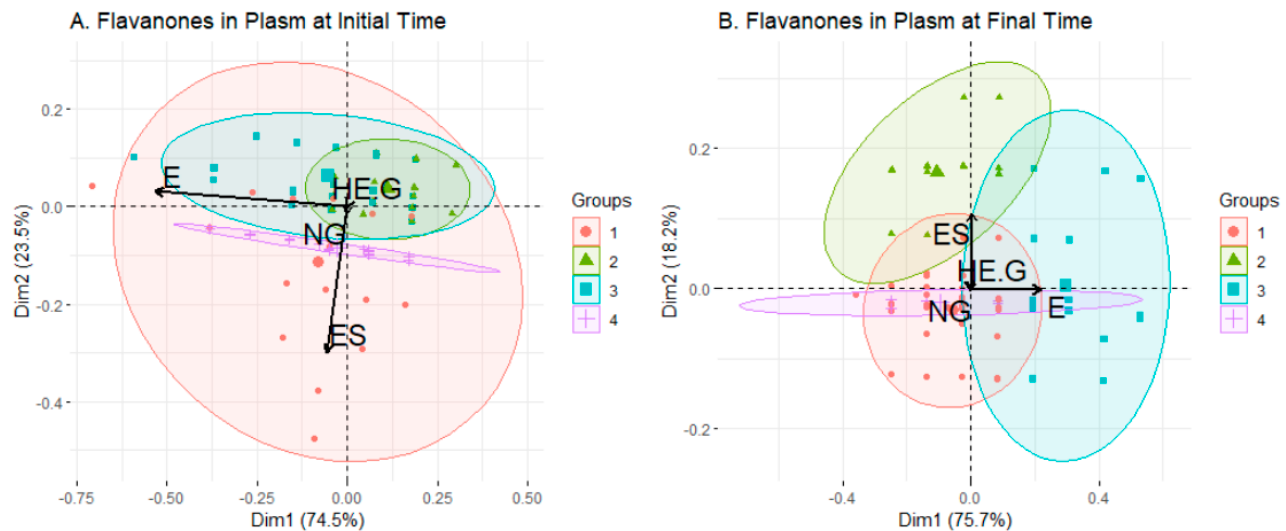
Figure 5. Biplot of the groups generated by clustering analysis applied to flavanones data set before ( A ) and after ( B ) consumption of the beverage. In black, the arrows showing the contribution to the composition of the clusters of the variables.